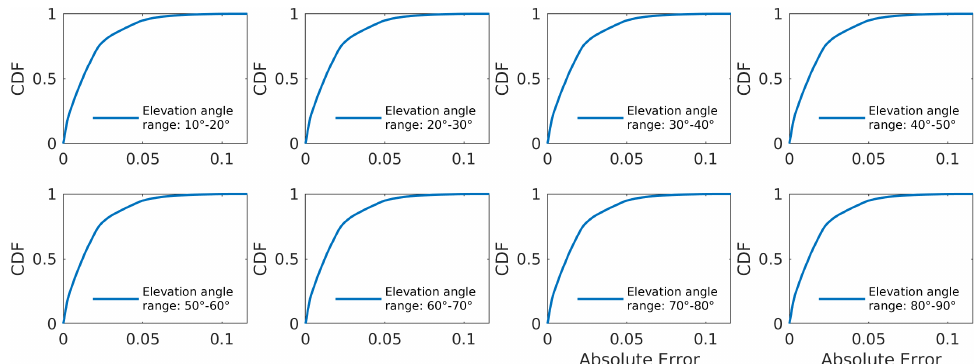
Figure 17. CDF’s of the absolute error by elevation angle range for all the simulated orbits and ES’s.